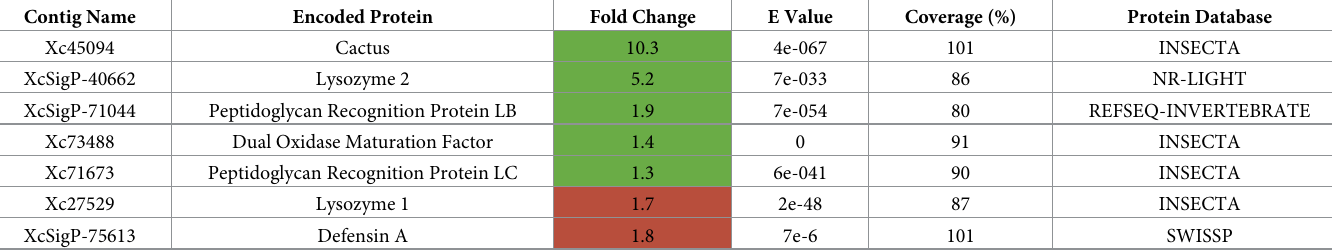
Table 4. Selected immunity genes differentially expressed in response to feeding and infection. Contig